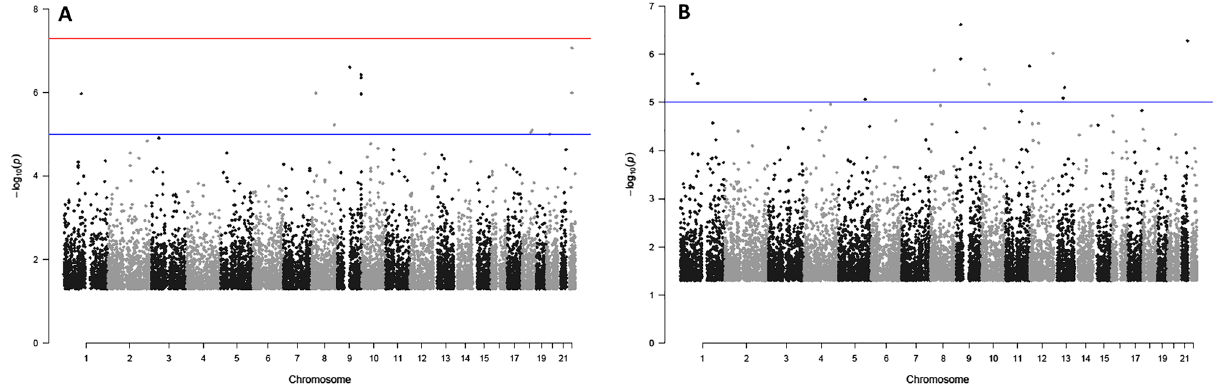
Figure 2. Manhattan plots of Shannon index-specific mbQTLs. ( A ) V1-V2-V3 dataset. ( B ) V4-V5-V6 dataset. Red horizontal line, threshold for genome-wide significance ( P = 5.0 × 10 –8 ). Blue horizontal line, FDR =